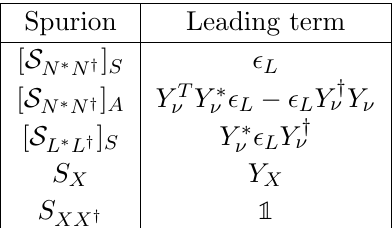
Leading scaling of the spurions analyzed in section 5 and section 6, where X = e; u; d; q; L; N . All terms have generic O (1) factors that we do not write